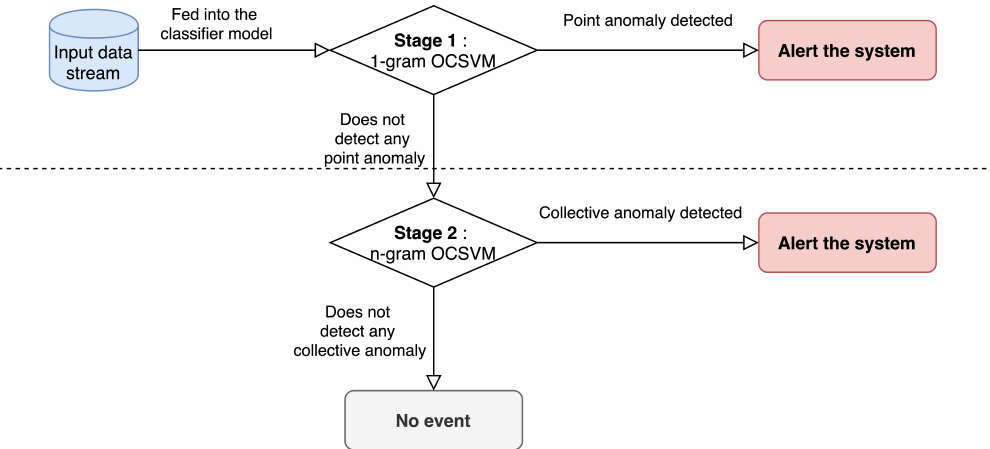
Figure 3. Architecture of dual-staged cascade one class support vector machine